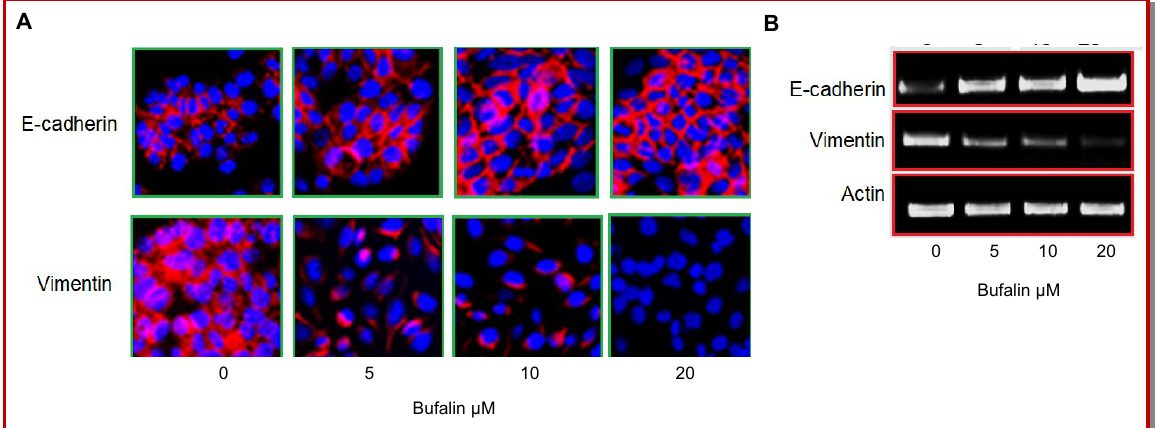
Figure 4: Bufalin inhibits the epithelial-to-mesenchymal transition of gastric cancer cells, in vitro . (A) Immunostaining of E- cadherin and vimentin marker proteins from MGC-803 cancer cells incubated without or with 5, 10 or 20 µM bufalin at 37 o C for 24 hours; (B) western blotting of E-cadherin and vimentin marker proteins from MGC-803 cancer cells incubated without or with 5µM, 10 µM or 20 µM bufalin at 37 o C for 24 hours. Each experiment was performed with three